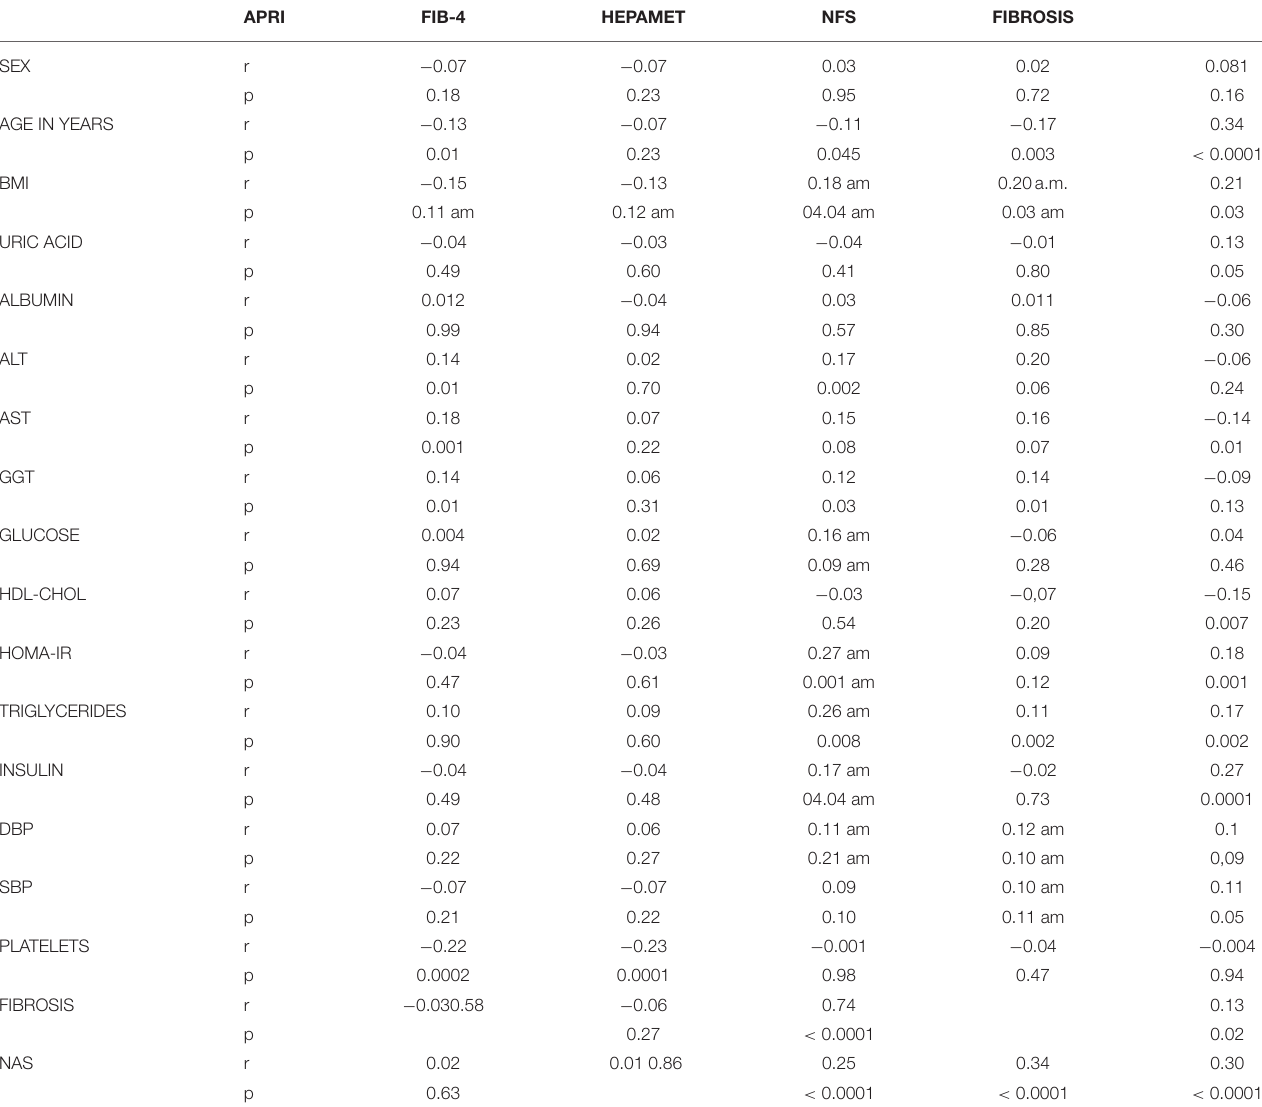
TABLE 4 | Correlations between NAFLD scores, fibrosis and anthropometric and laboratory characteristics. APRI FIB-4 HEPAMET NFS